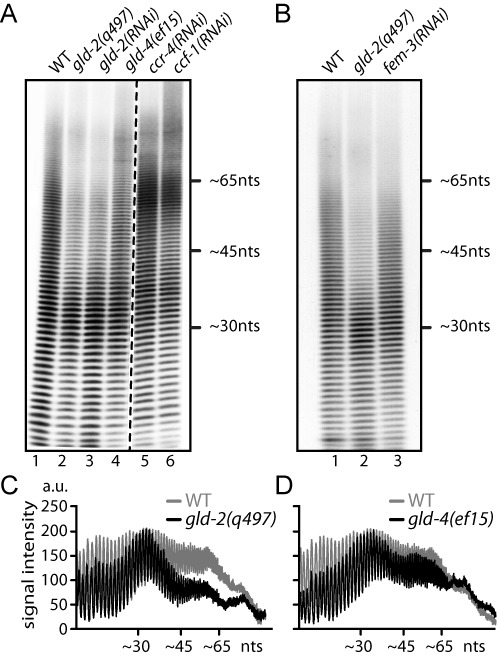
gld-2 promotes bulk mRNA poly(A) tail extension. (A and B) Representative gels of at least three independent bulk poly(A) tail measurements. Equal amounts of radioactivity were loaded for each sample. WT, wild-type. (C and D) Line scans of bulk poly(A) profiles from (A).